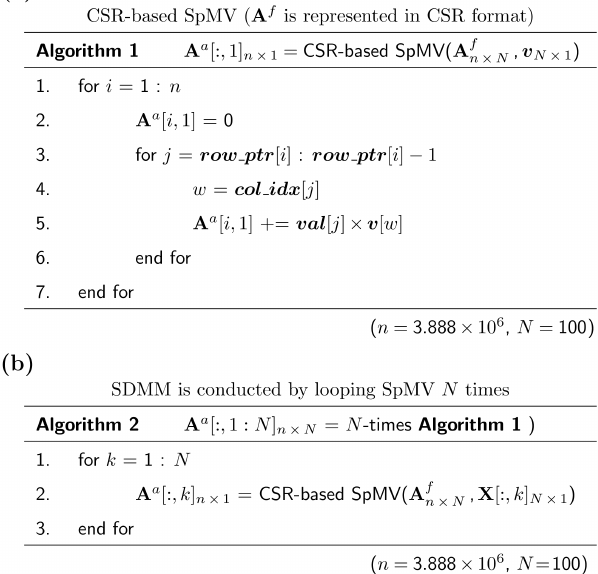
Figure 4. Algorithms for CSR-based SDMM to compute the mul- tiplication of sparse matrix A f and dense matrix X . (a) Multiplica- tion of A f by a column vector v (in X ) by CSR-based sparse matrix vector multiplication (SpMV). val , col _ idx , and row _ ptr are the three arrays to represent A f in CSR format. (b) Looping SpMV N times (each with one column of X ) to obtain A a = A a X